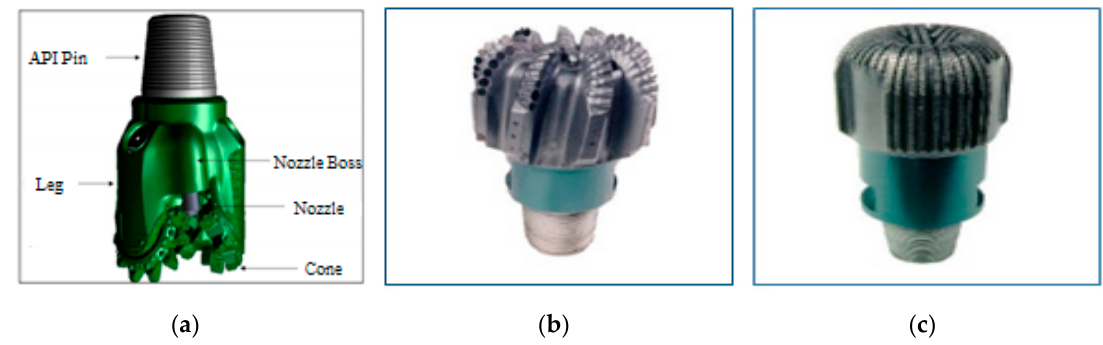
Figure 2. Types of drill bit: ( a ) bit anatomy, ( b ) matrix body of PDC bit, ( c ) natural diamond tricone bit.